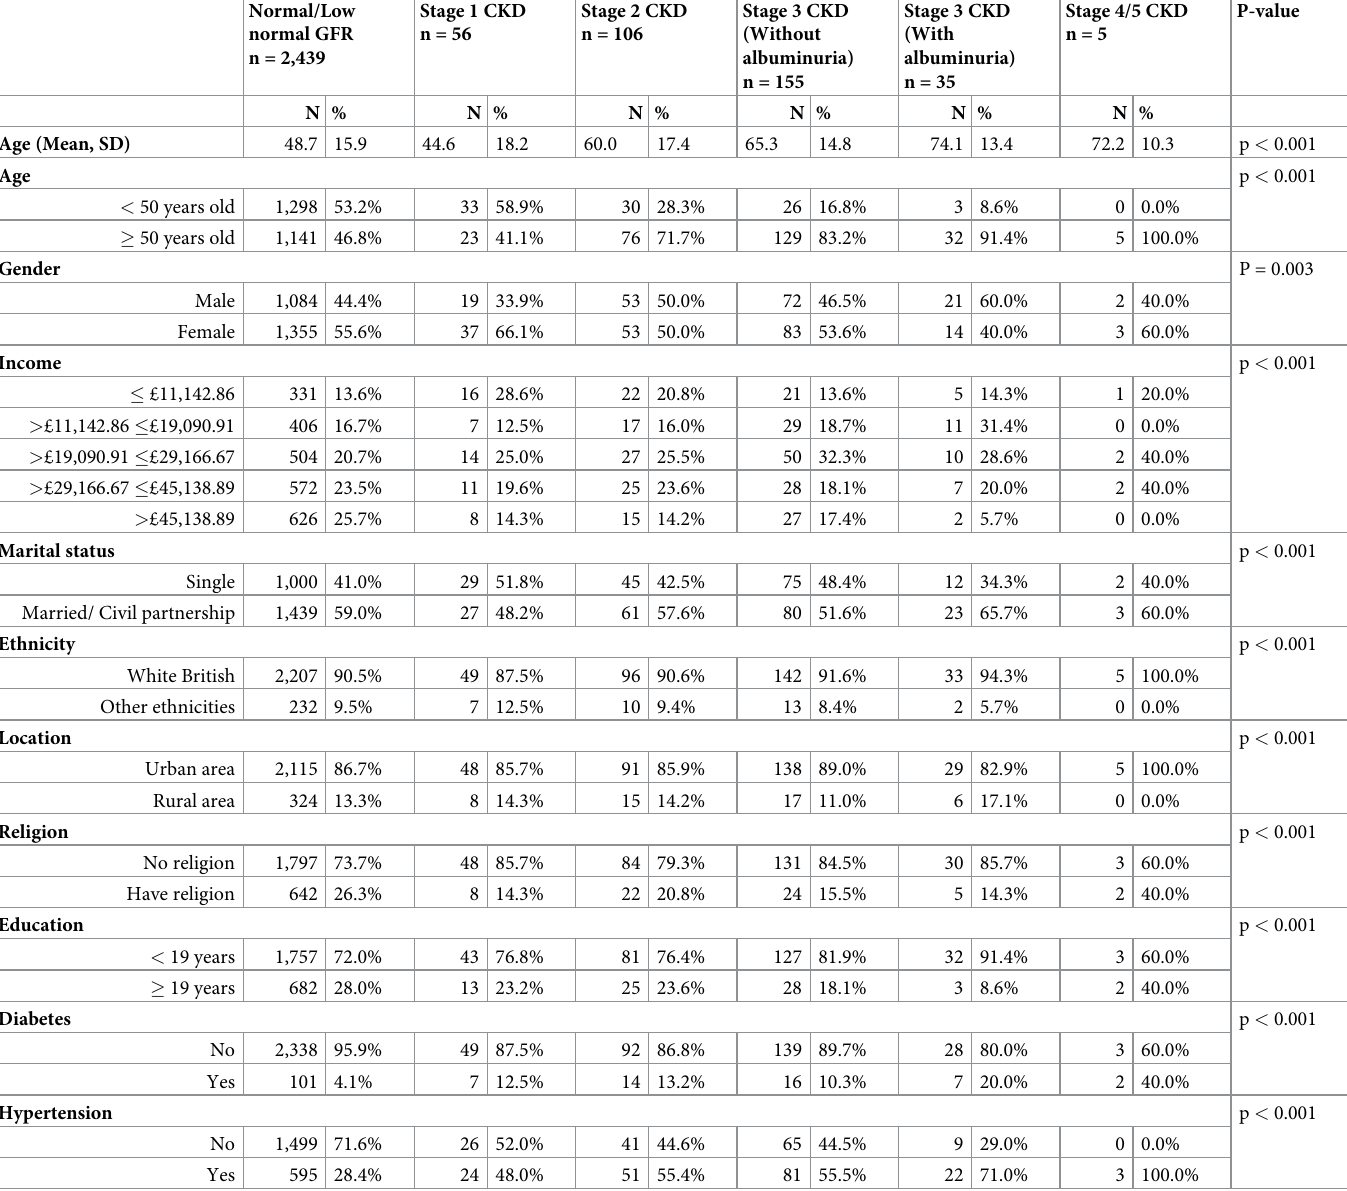
Table 1. Demographic characteristics, socioeconomic status and comorbidities of participants stratified to eGFR